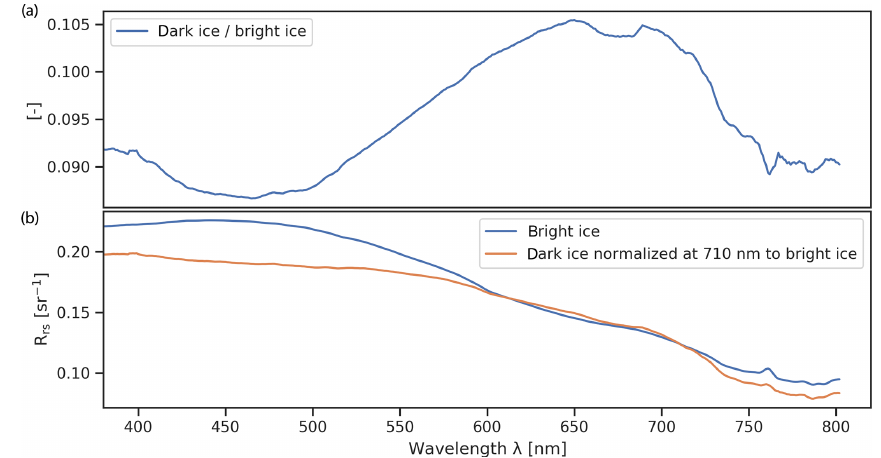
Figure 9. Quotient of bright and dark bare ice spectra (a) and R rs of bright ice and dark ice normalized at 710nm (b) .